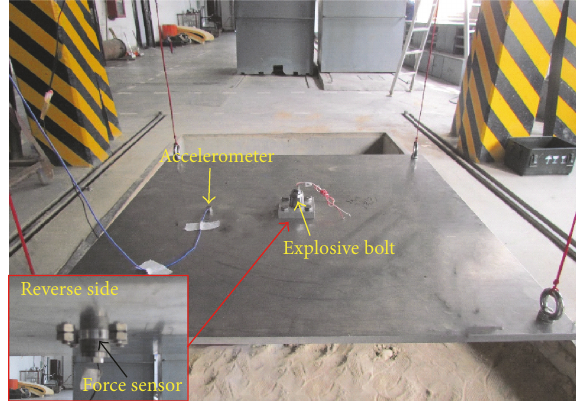
Figure 5: Measurement scene of output shock for explosive